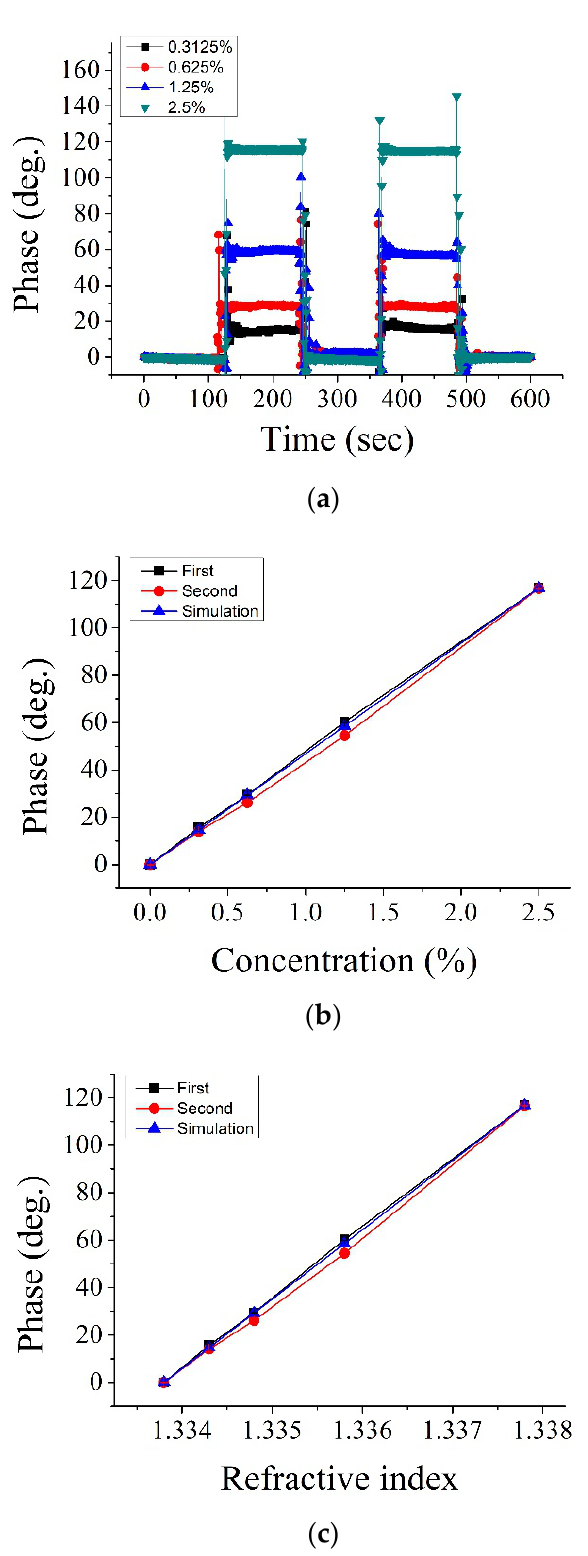
Figure 5. HCl solution measurement results: ( a ) phase variations by alternately exchanging the pure water and the different HCl concentrations; ( b ) phase versus concentration for two periods and the simulation results; ( c ) phase versus the RI.